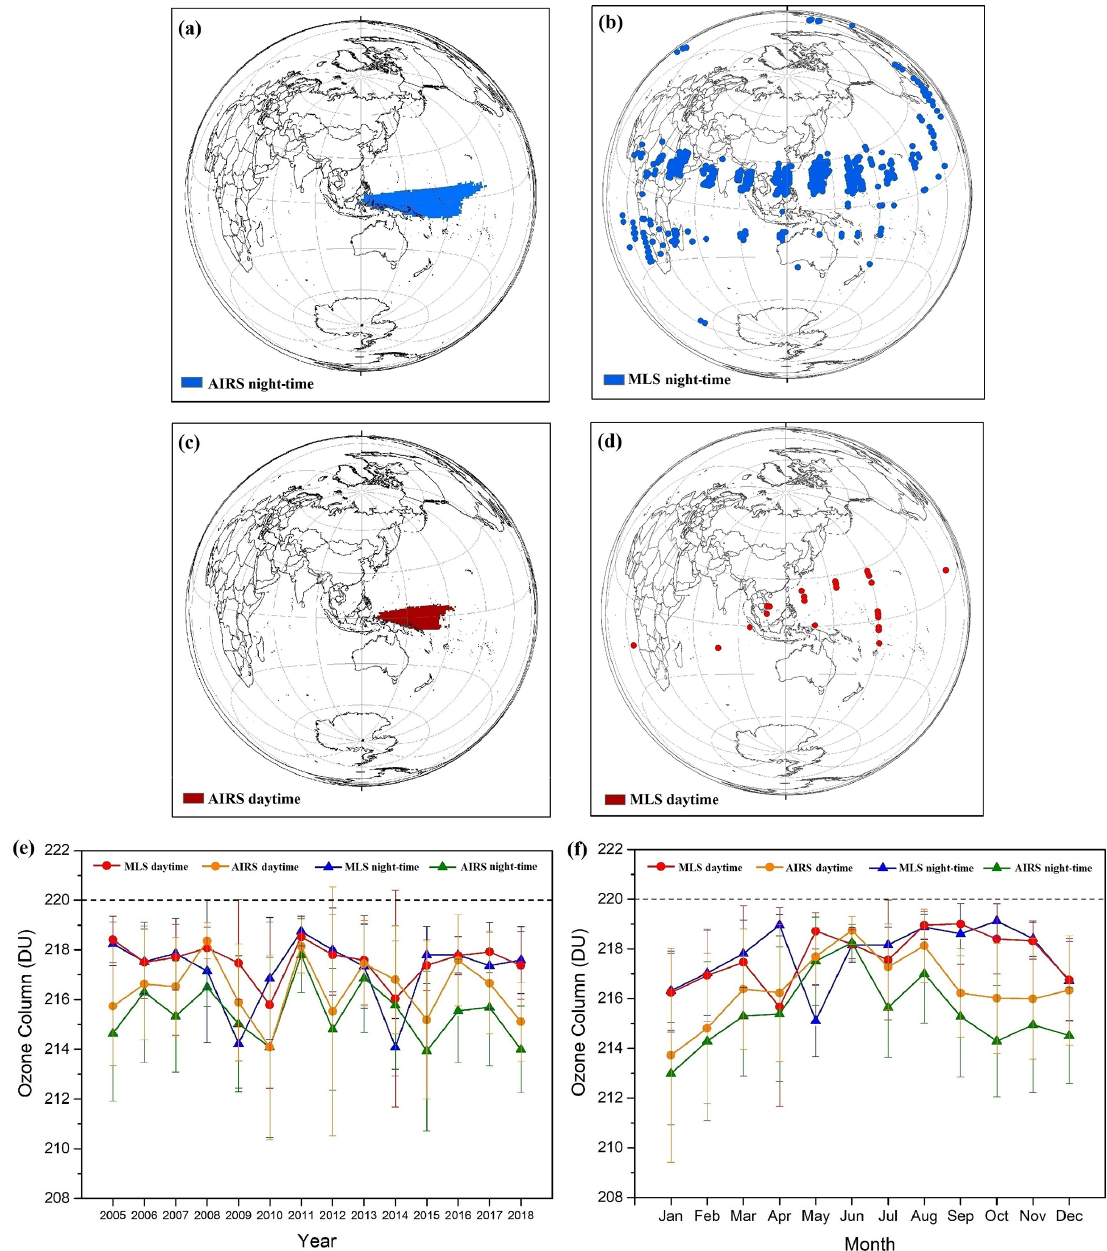
Figure 6. Spatial and temporal distribution of the low ozone. (a) Location (composite pixel) of the yearly night-time low ozone from 2005 to 2018 for AIRS TCO. Panel (b) is the same as panel (a) but for MLS SCO. (c) Location (composite pixel) of the yearly daytime low ozone from 2005 to 2018 for AIRS TCO. Panel (d) is the same as panel (c) but for MLS SCO. (e) Yearly averaged AIRS TCO and MLS SCO of the low-ozone regions for 2005–2018. (f) Monthly averaged AIRS TCO and MLS SCO of the low-ozone regions for 2005–2018. Uncertainties represent the standard deviation of the measured